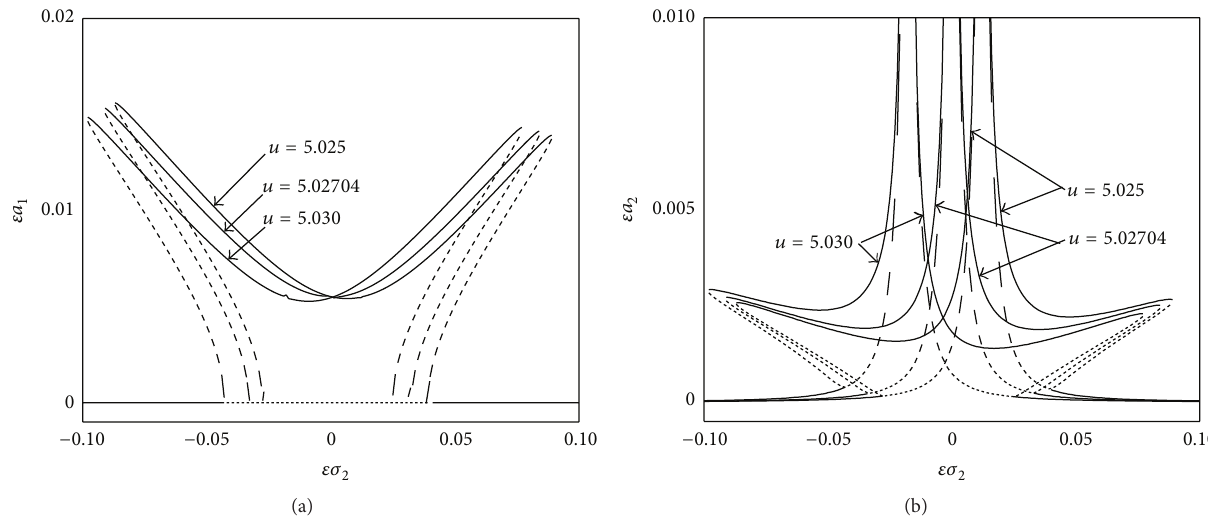
Figure 5: Amplitude-frequency curves of first subharmonic resonance for different flow speeds: (a) the first mode and (b) the second mode.